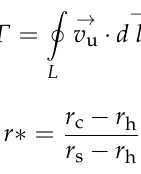
Figure 9. The comparison of TEP of pump components between guide vanes and volute scheme under ( a ) 800 m 3 /h, ( b ) 1200 m 3 /h, and ( c ) 1600 m 3 /h.